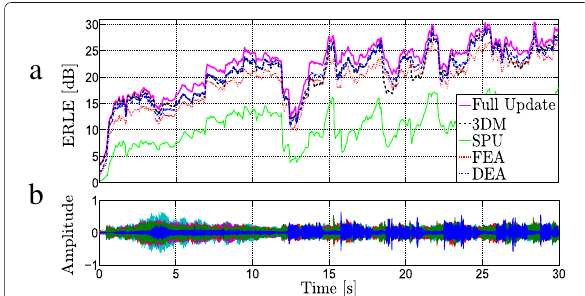
Fig. 12 ( a ) ERLE curves obtained for full update ( Q = 1) and for different tap selection schemes ( Q = 0.2) for a 30 -s segment of a 5-channel concert signal; ( b ) waveform of the 30 -s segment of a 5-channel concert signal